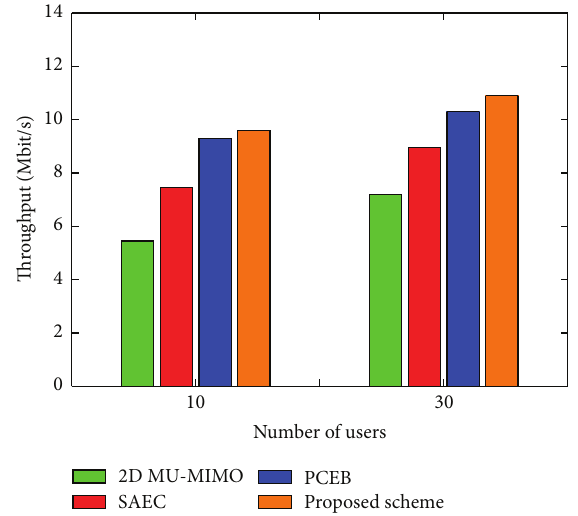
Figure 11: The throughput comparison when UE is distributed over the whole cell.